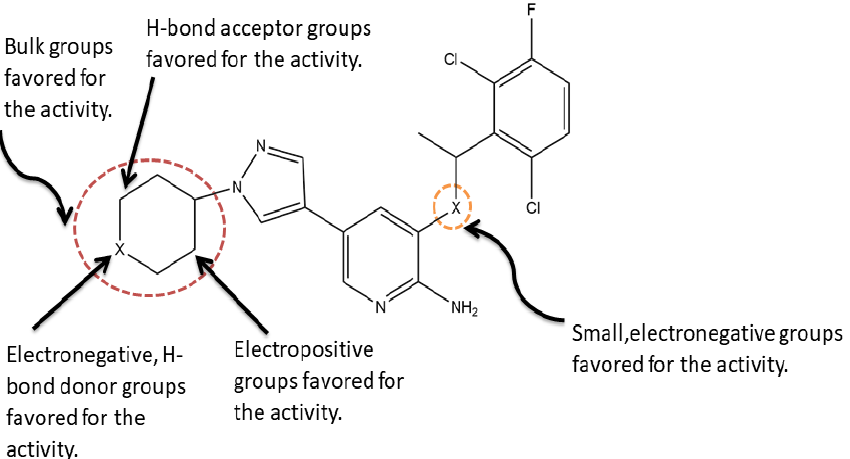
Figure 13. Graphical representation of SARs derived from CoMFA and CoMSIA analysis. All the groups mentioned above are beneficial to the inhibition activity.